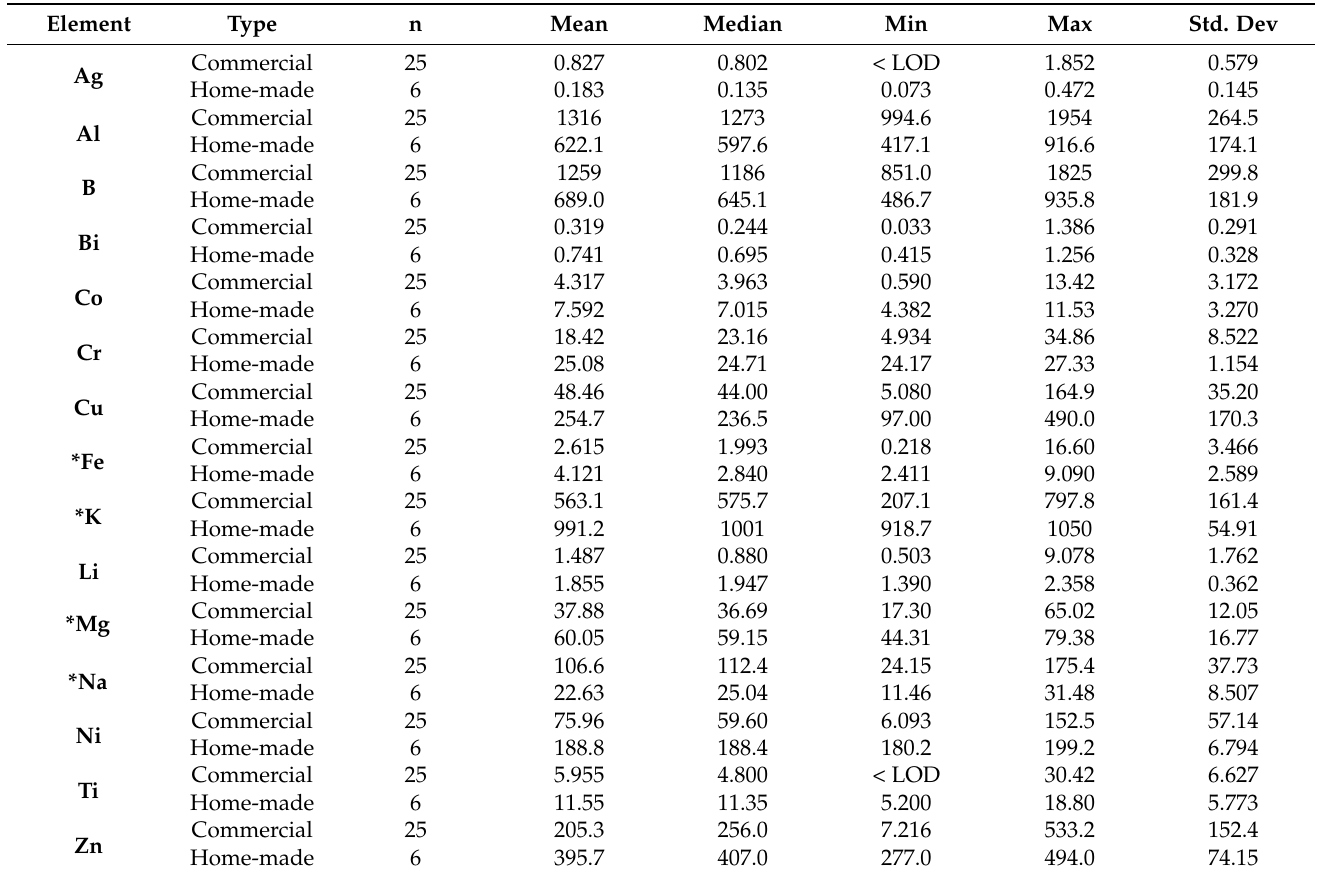
Table 6. Contents of selected elements (with statistically significant differences) in the measured home-made cider (n = 6) and commercial cider samples (n = 25) [ µ